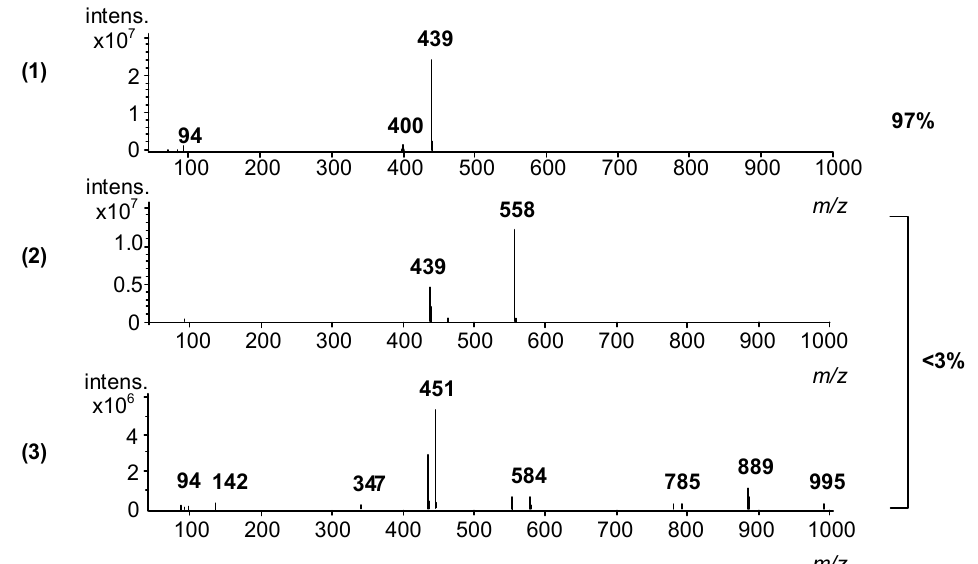
Figure 3. ESI + mass spectra of fractions of benzoxazine synthesized according to Scheme 1. Retention time of fractions: 13.4 ( 1 ), 15.4 ( 2 ) and 17.6 min ( 3 ).